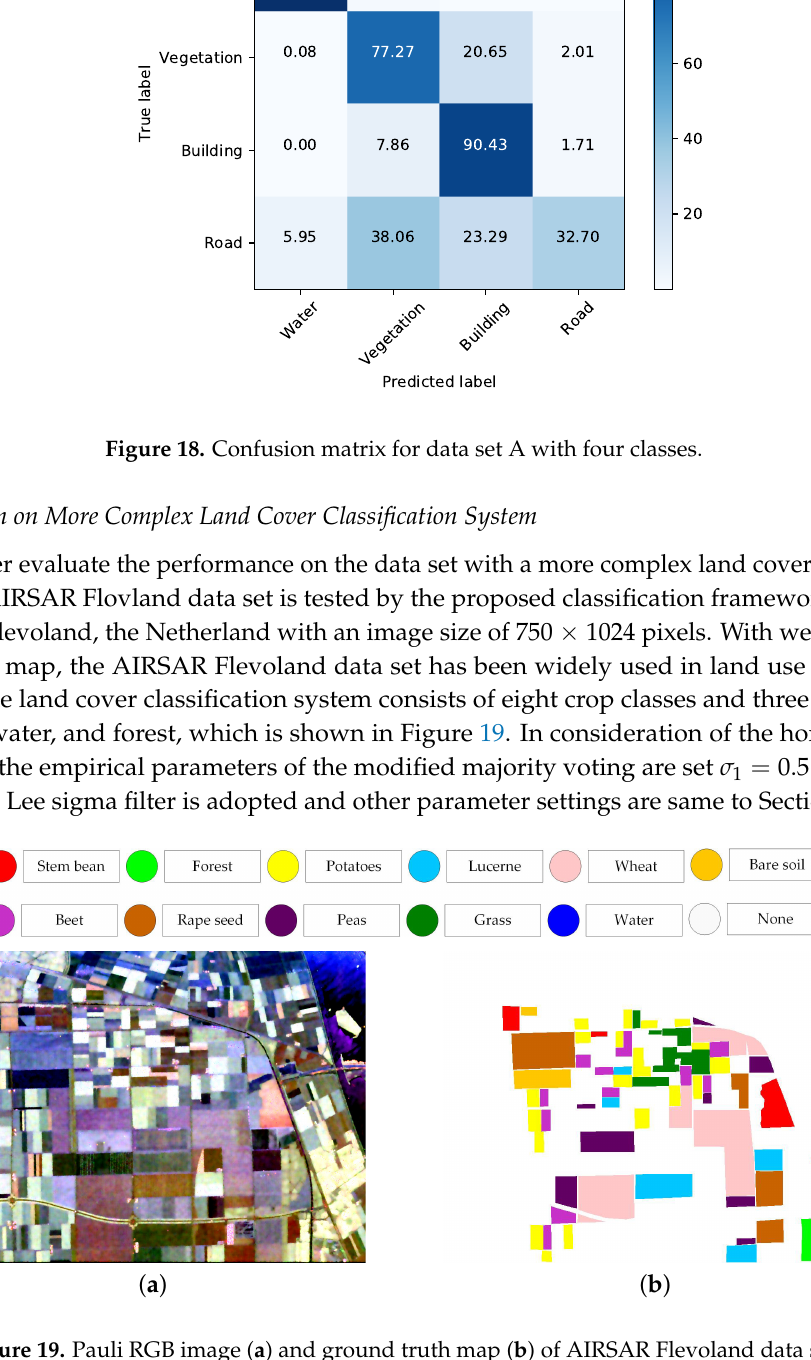
Figure 19. Pauli RGB image ( a ) and ground truth map ( b ) of AIRSAR Flevoland data